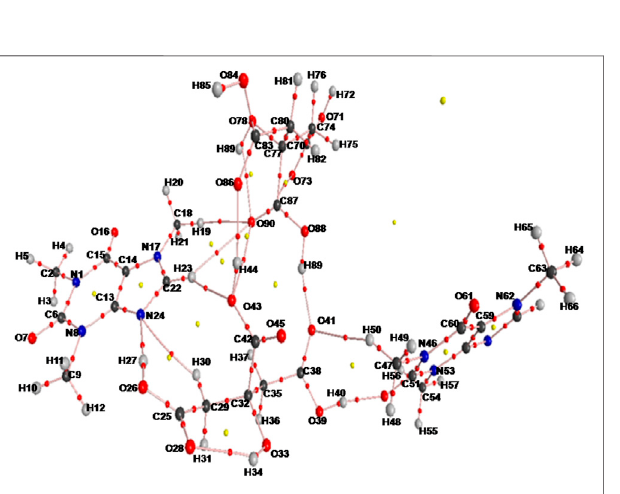
Frontiers in Chemistry |